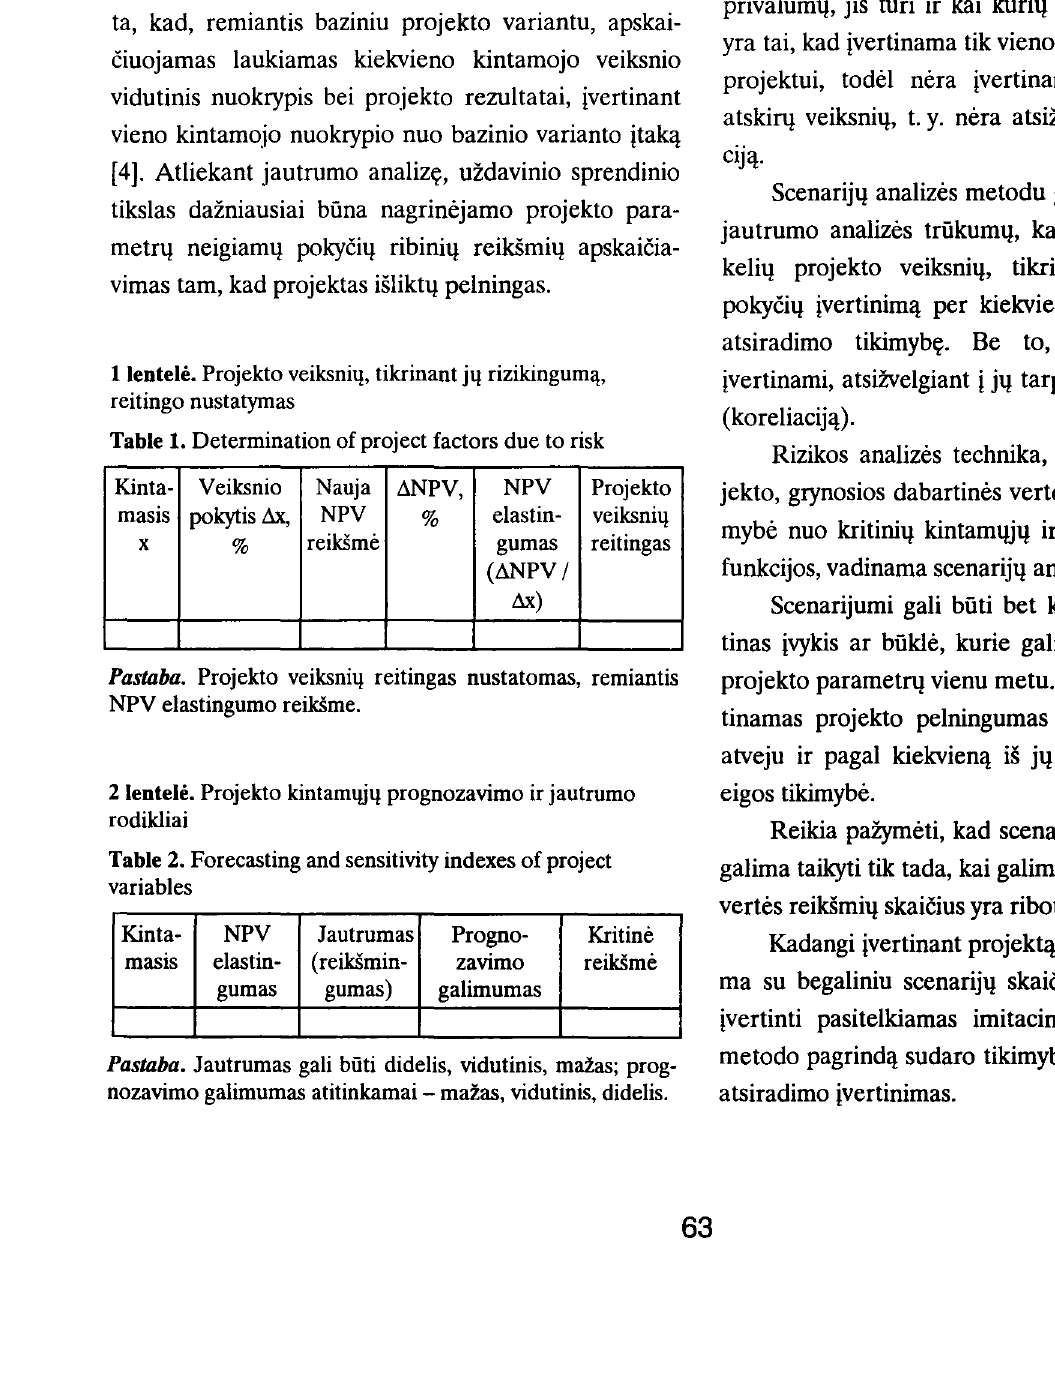
Pastaba. I - reikia tolesnio patikrinimo; II - toliau